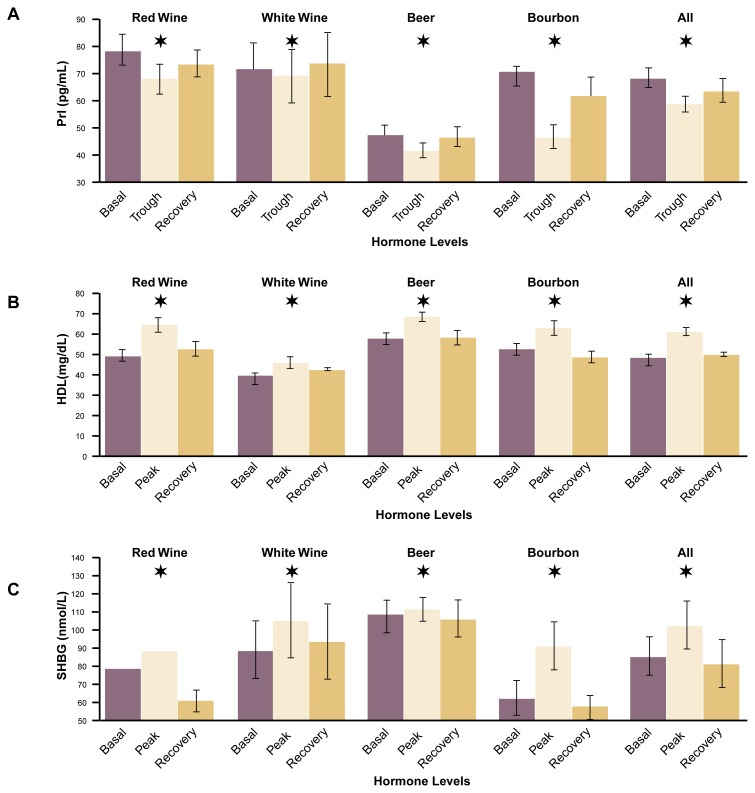
Effects of alcoholic beverage congeners on the levels of (A) prolactin (Prl), (B) high-density lipoprotein (HDL) cholesterol, and (C) sex hormone-binding globulin (SHBG) in postmenopausal women. For 4 weeks, the women consumed congener amounts corresponding to those present in one standard drink of the beverage daily. Basal hormone levels were determined before the women began the experiment. Peak levels represent the highest hormone levels that were detected during the 4-week administration period of alcoholic beverage congeners. Recovery levels were determined 1 week after the last ingestion of congeners. All congeners had estrogenlike effects (i.e., resulted in elevated levels of Prl, HDL cholesterol, and SHBG). The effects of the various congeners did not differ significantly.